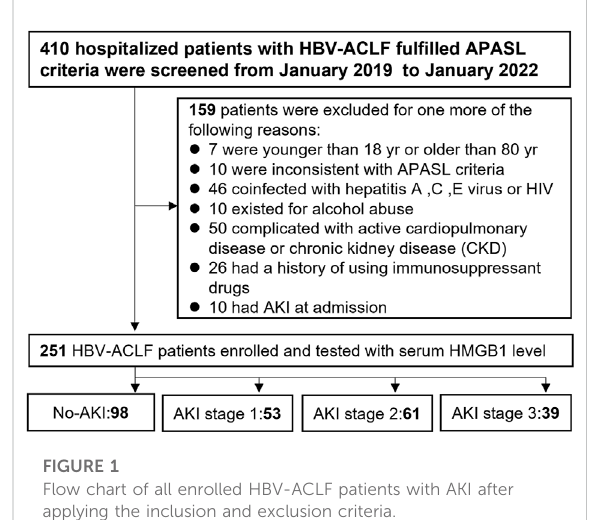
FIGURE 1 Flow chart of all enrolled HBV-ACLF patients with AKI after applying the inclusion and exclusion